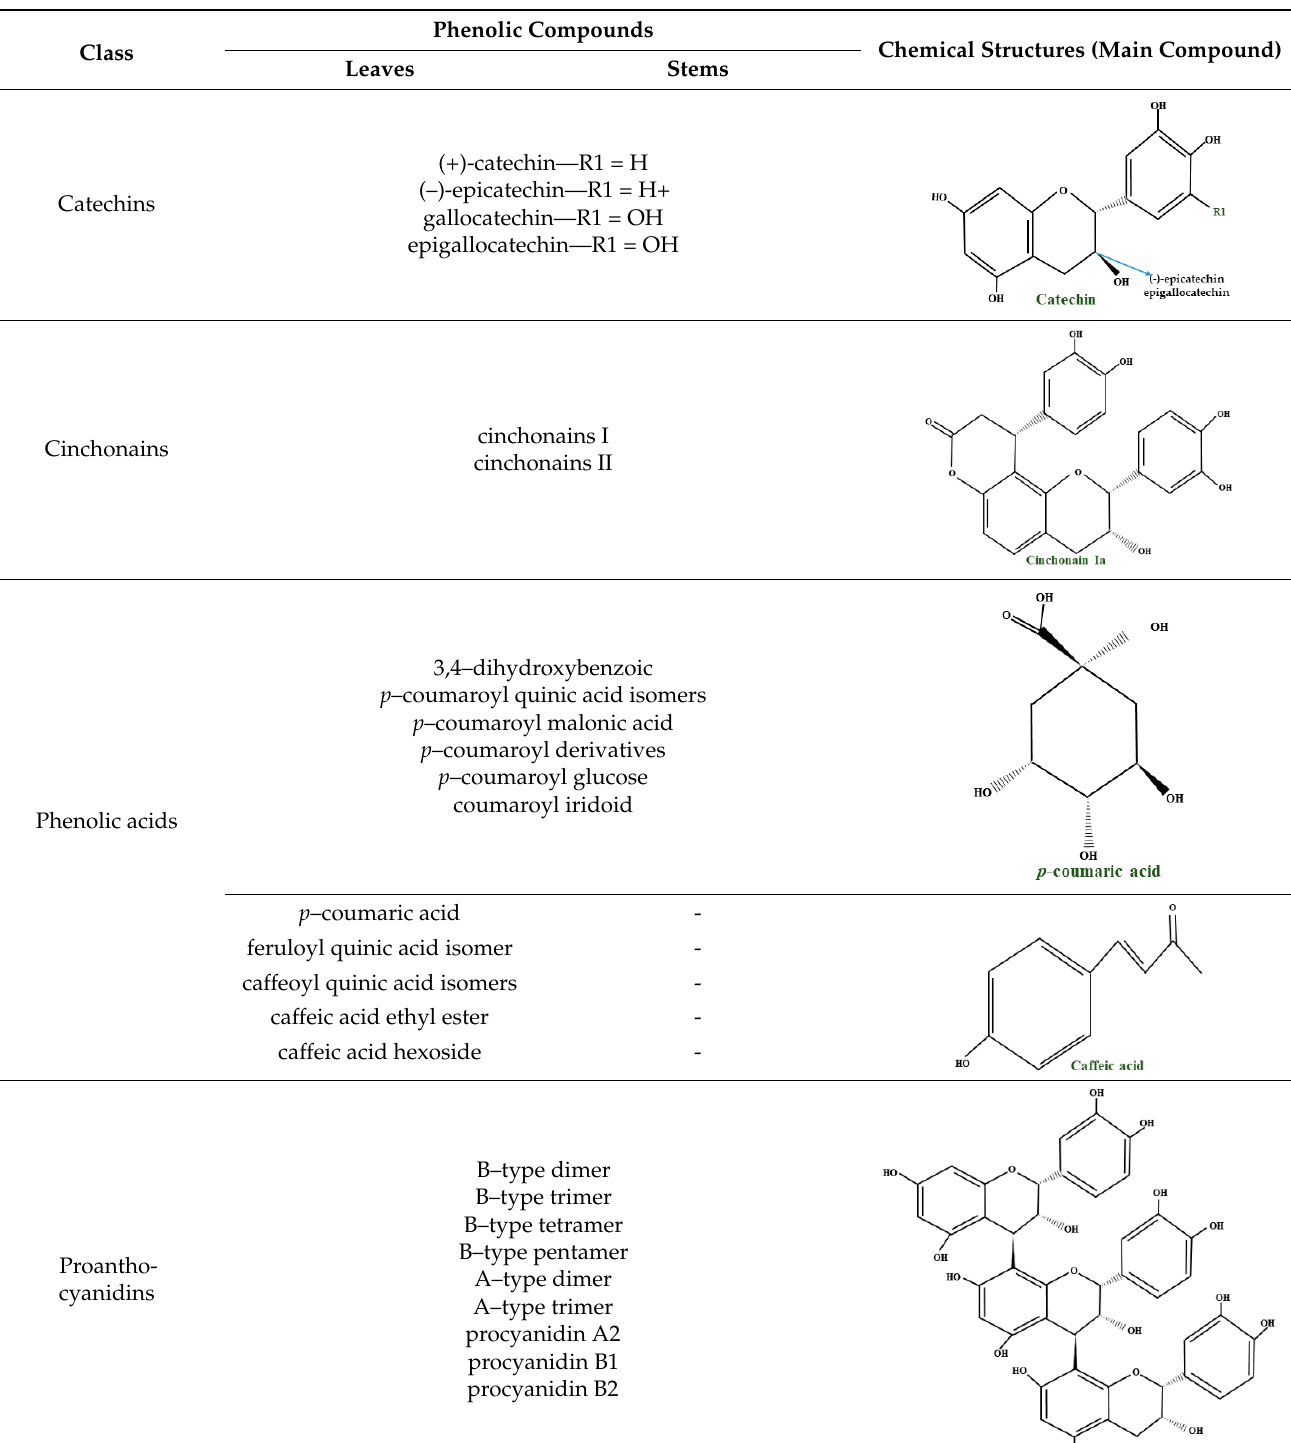
Table 1. Phenolic compounds identified in aerial parts of Vaccinium plants.